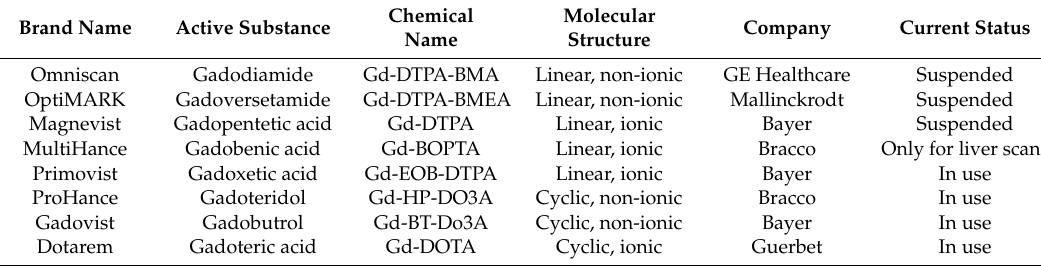
Table 1. Magnetic resonance imaging contrast